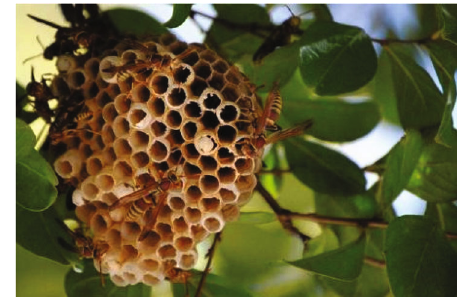
Figure 1: Honeycomb in nature.